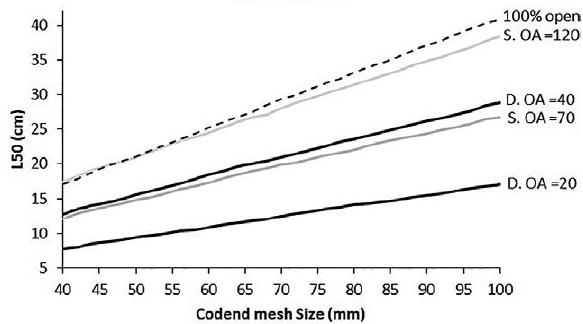
Fig 7. – L50 vs. mesh opening angle for 50 mm diamond from FISHSELECT and 50 mm diamond mesh for the Sala and Lucchetti Fig. 8. – Expected ranges for L50 versus mesh size for both dia- (2011) model (unfilled square). Black square is the prediction for mond and square mesh codends. The dashed black line represents 280 meshes in circumference. The curve and black diamonds repre- fully open mesh, black solid lines represent minimum (20°) and sent FISHSELECT L50 values. maximum (40°) opening angles for diamond mesh codends and grey solid lines minimum (70°) and maximum (120°) opening angles for square mesh codends.